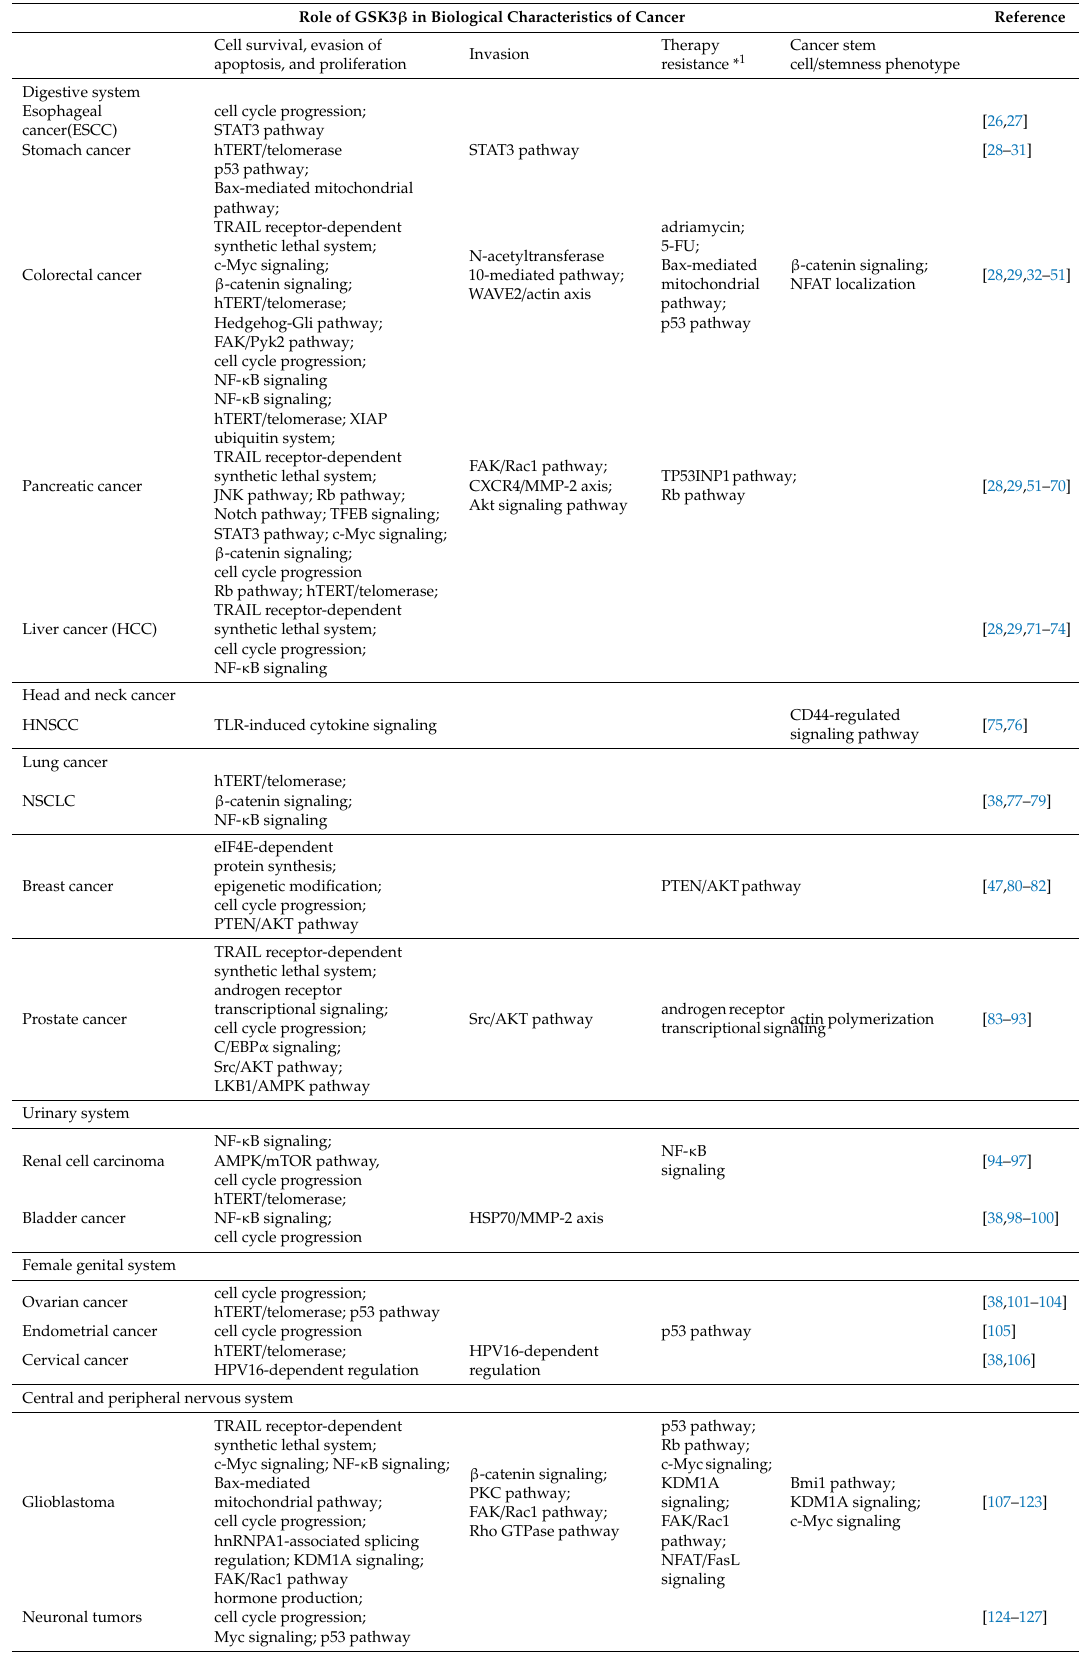
Table 1. Tumor-promoting property of GSK3 β reported in various cancer types. Role of GSK3 β in Biological Characteristics of